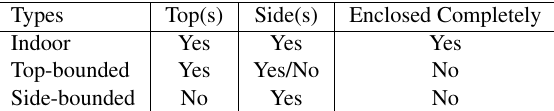
Table 1. Characteristics of environments (spaces) formed by built structures.